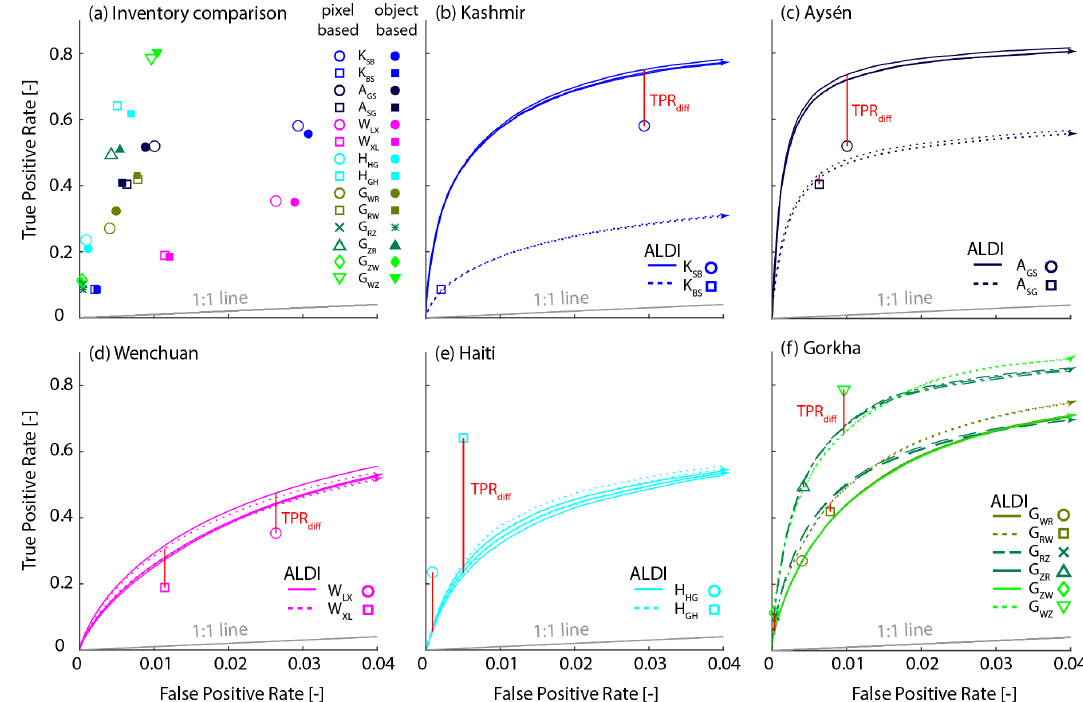
Figure 6. (a) TPR and FPR pairs for the 14 inventory cross comparisons. Open symbols are calculated from a pixel-based analysis at 30m resolution; solid symbols are calculated from an object-based analysis using mapped polygons. The grey line shows the naïve (random) 1:1 relationship. Note the difference in x - and y -axis scales for this and all other panels. (b) – (f) ROC curves for ALDI for each case study. There are three ROC curves for ALDI evaluated against each check inventory (e.g. K SB ) all with the same line style (solid or dashed). In every case the upper curve is from ALDI with locally optimised parameters; the middle curve (indicated with an arrowed end) is from ALDI with global parameters; and the lower curve is from ALDI with holdback parameters. The global and holdback curves are indistinguishable in almost all cases. Red lines indicate the value of TPR diff , the difference in TPR between ALDI and the competitor inventory when both are evaluated using the same check inventory. Legend acronyms indicate the study site (e.g. K ) with the check and then competitor inventory labels as subscripts; see Table